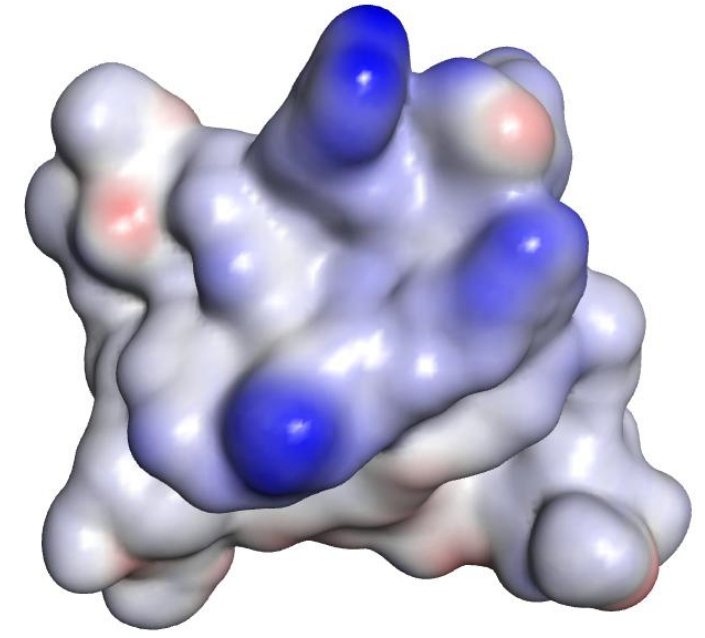
Figure 1. Molecular electrostatic potential (MEP) of one complex formed by one molecule of compound 6 (peptide sequence WRWRW-NH 2 ) and three novobiocin molecules. The hydrophilic positively charged side chains (blue) are protruding from the complex. Hydrophobic regions are shown in grey and negative dipoles in red.